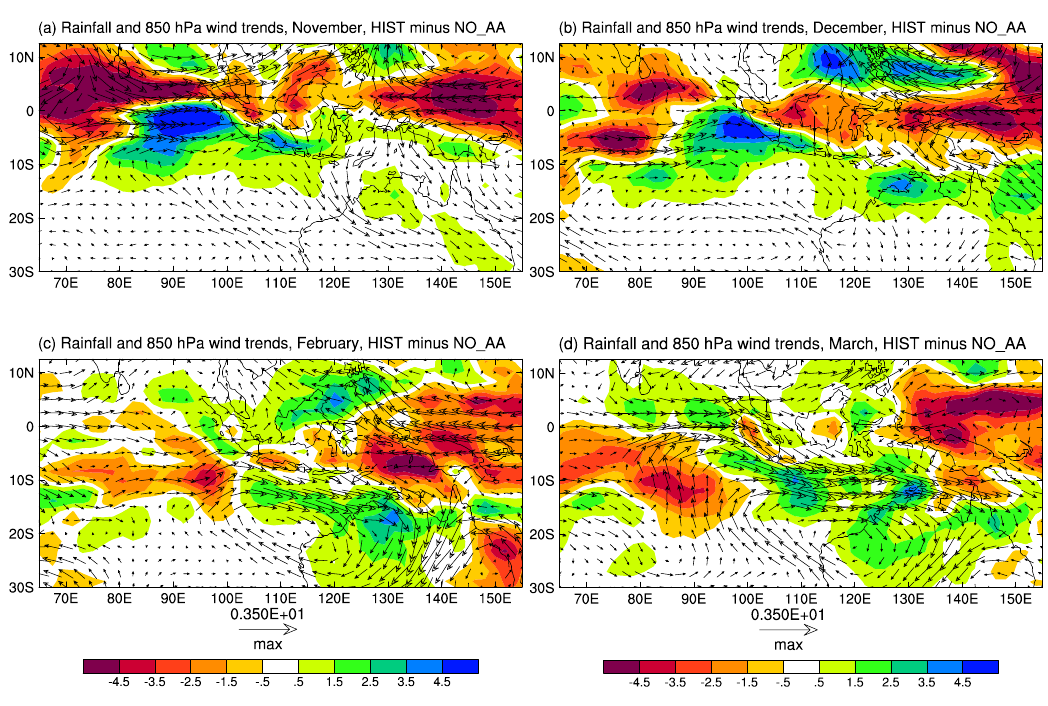
Fig. 21. 1951–2010 HIST minus NO AA ensemble-mean trends of rainfall (shading, mmday − 1 century − 1 ) and 850 hPa wind (vectors,